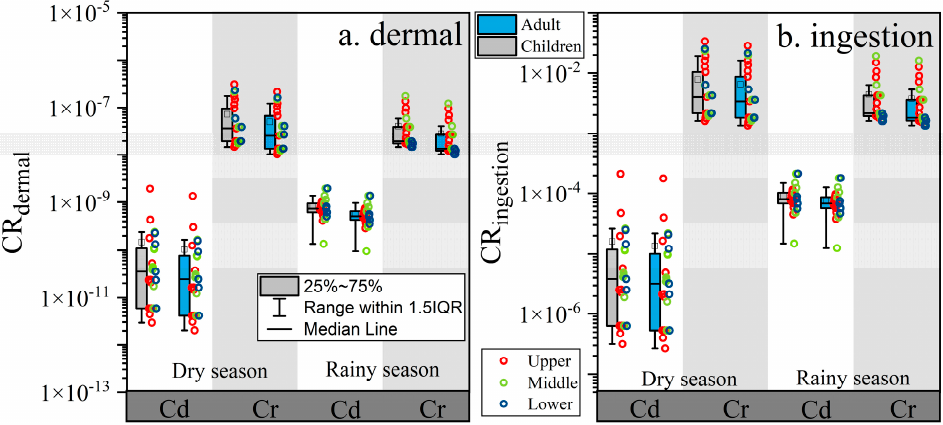
Figure 6. Carcinogenic risks of Cd and Cr for children and adults in the Fuhe River watershed,